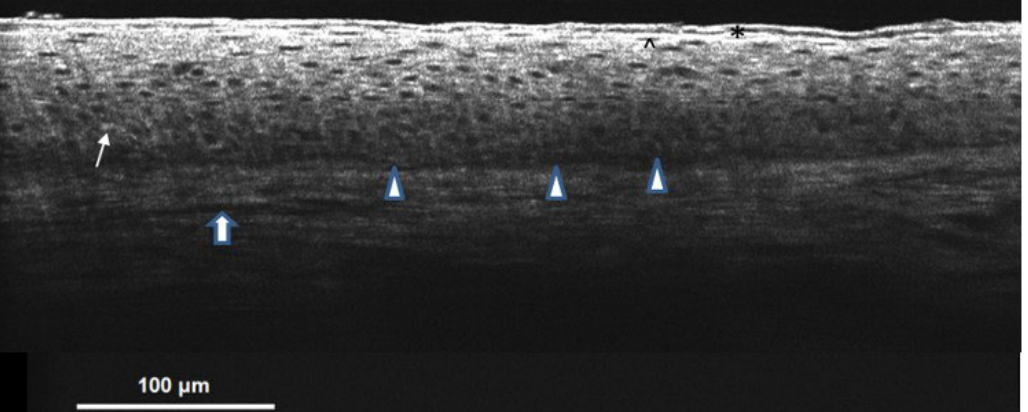
Figure 6. Normal skin on cellular resolution OCT. The stratum corneum is composed of a thin upper hyper-reflective layer and a gray-black zone underneath (shown in *). Then, there is a thin layer of hyper-reflective cells suggesting stratum granulosum (shown in ^), followed by a grayish thicker stratum spinosum layer with round, small, hyporeflective keratinocytes. The hyper-reflective melanin (shown in the arrow) is intermittently presented in the basal cell layer. The epidermis and dermis separated by the dermal–epidermal junction can be clearly illustrated (shown in ). The dermal area showed a heterogeneous pattern with dark linear blood vessels (shown in ) embedded.